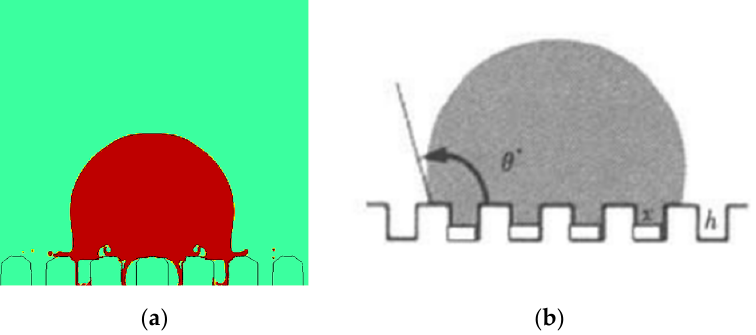
Figure 10. Comparison of droplet spreading morphology between numerical simulation and the Cassie–Baxter model. ( a ) Numerical simulation. ( b ) The Cassie-Baxter model [31].